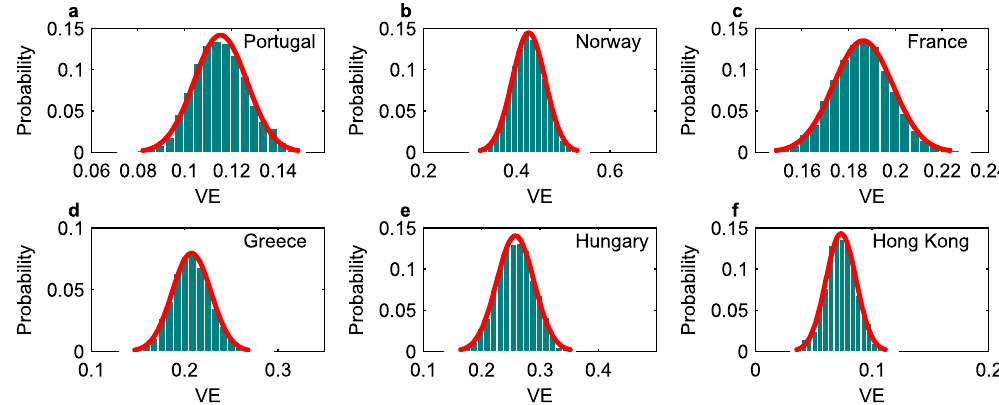
Figure 3. Posterior distributions for heptavalent vaccine efficacy against PCV7 serotypes, estimated in a setting-specific manner. Parameter inference is based on dynamic model fitting to cross-sectional data in day care settings from different countries, accounting for different transmission intensities, initial serotype distribution, and vaccine coverage. Red lines indicate normal distribution fits. Numerical results are detailed in Table